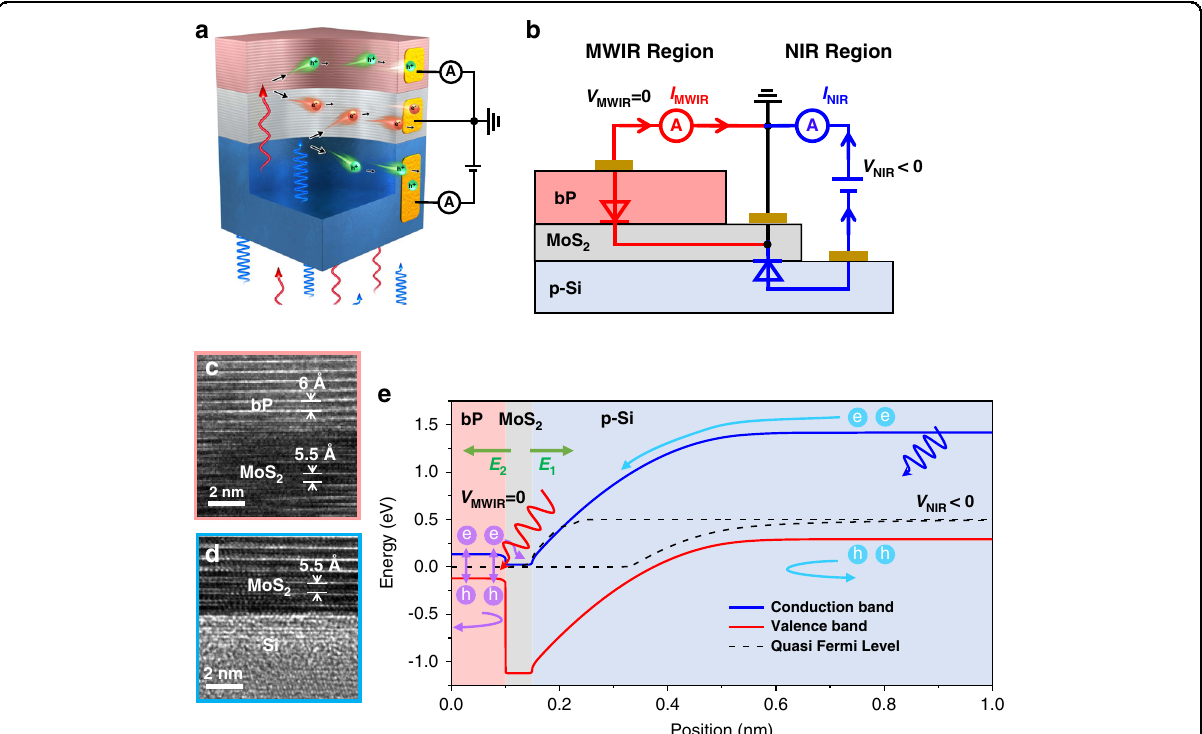
Fig. 1 BP/MoS 2 /Si van der Waals two-color infrared detector concept. a Schematic of van der Waals two-color infrared photodetector, showing the working mode and external circuit of the photodetector. b Circuit con fi guration of device to demonstrate the performance of two-color photodetector. c Cross-sectional TEM image showing the bP/MoS 2 interface. d Cross-sectional TEM image showing the Si/MoS 2 interface. e Simulated energy band diagram with p-Si applied a negative